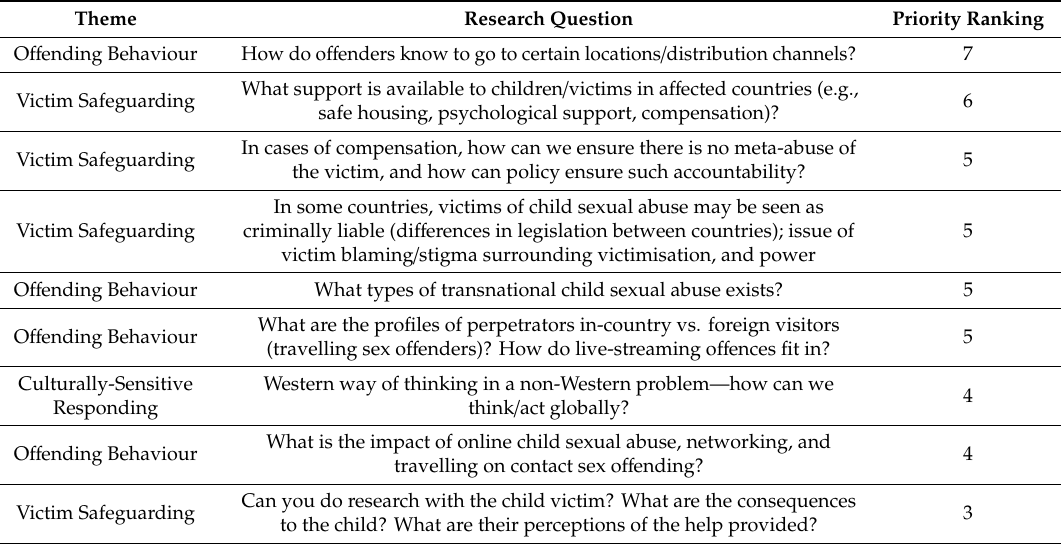
Table 1. Identified research questions, prioritised by the group (frequency